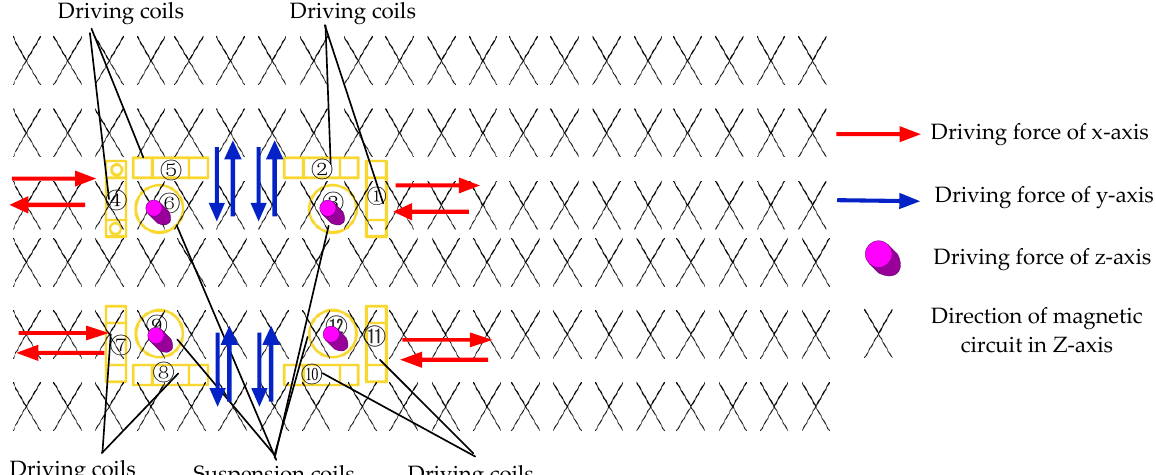
Figure 2. Working principle of the 6-DOF magnetic suspension platform.